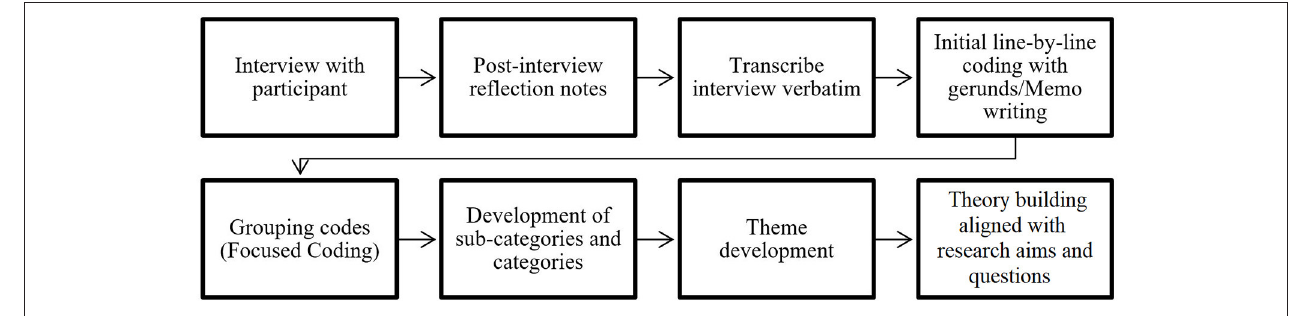
FIGURE 1 | Constructivist grounded theory data collection and analysis